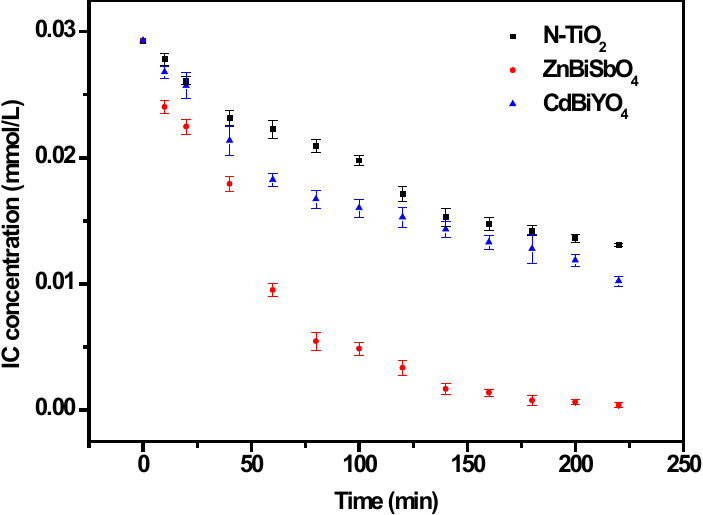
Figure 10. Photocatalytic degradation of IC under visible light irradiation with the presence of ZnBiSbO , CdBiYO and N-TiO as photocatalysts, respectively. The results are means 4 4 2 of triplicates, and error bars represent ±1